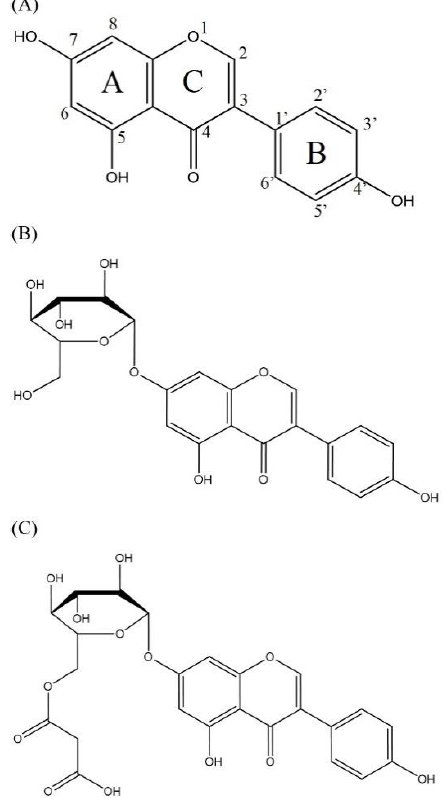
Figure 1. The molecular structure of genistein in ( A ) aglycone form (genistein), ( B ) glycoside form (genistin) and ( C ) conjugated beta-glycoside form (6”- O -malonyl genistin).